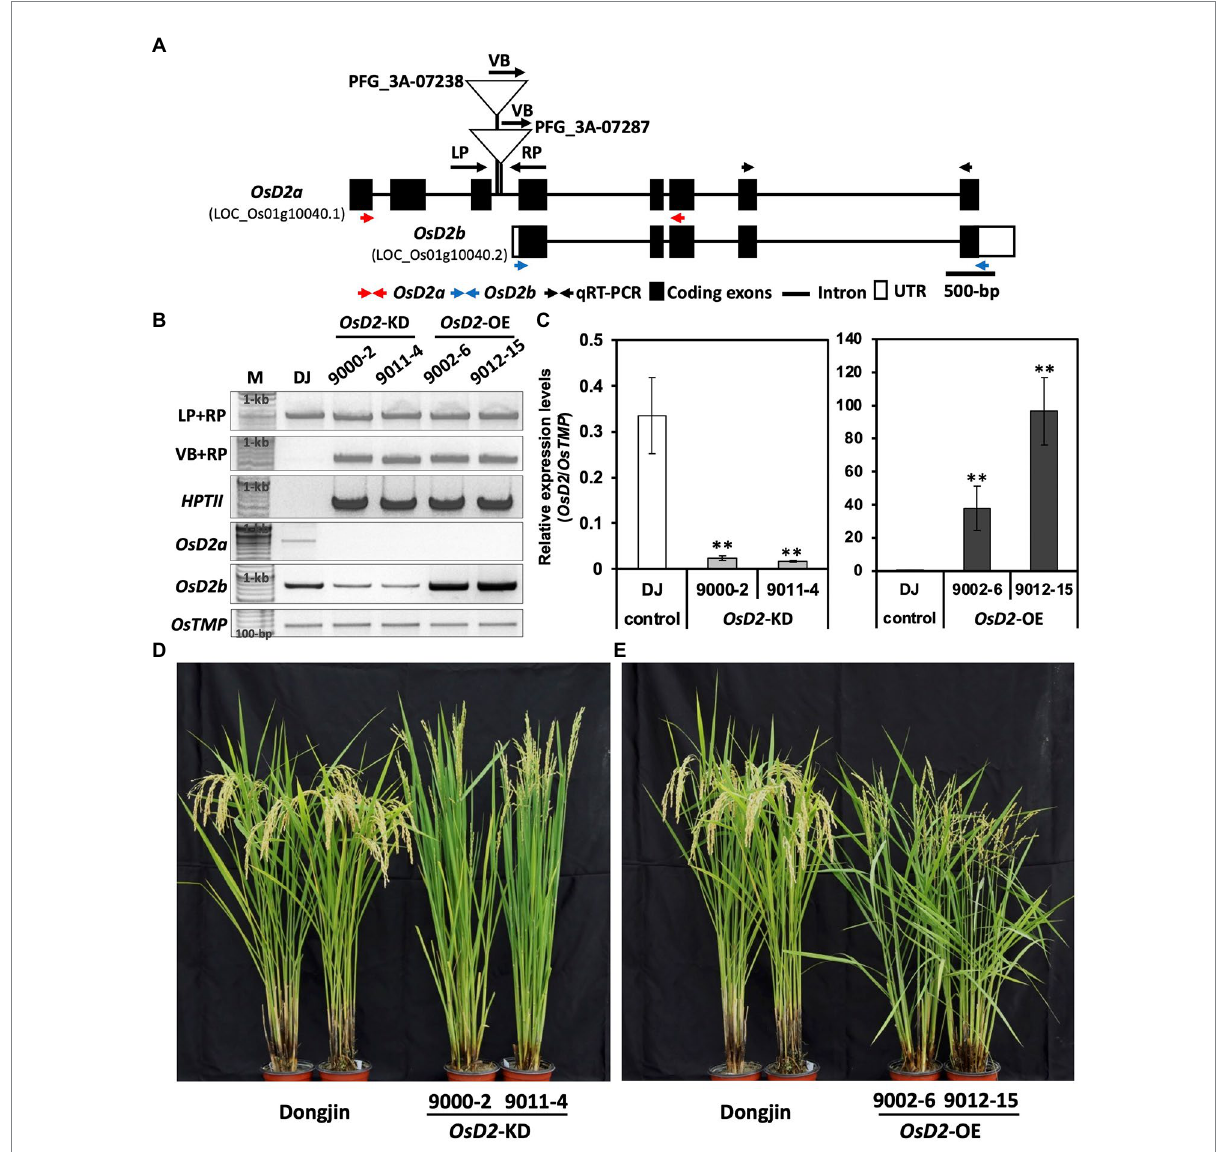
FIGURE 3 Characterization of T-DNA insertion lines. (A) Gene structure of OsD2 and T-DNA insertion sites in two lines. VB, vector border; LP, left primer; and RP, right primer. (B) PCR amplicons to confirm T-DNA insertion together with hygromycin resistant gene ( HPTII ) and PCR amplicons for transcript form confirmation of OsD2a and OsD2b using cDNA. M: 100-bp size marker, DJ: Dongjin. (C) Gene expression level of OsD2 in the T-DNA insertion lines. OsTMP was used for gene normalization. Error bars indicated SD. ** indicates a significant difference between each T-DNA insertion line and Dongjin based on the Student’s t -test at p < 0.01. (D,E) Phenotypic difference between Dongjin and T-DNA insertion